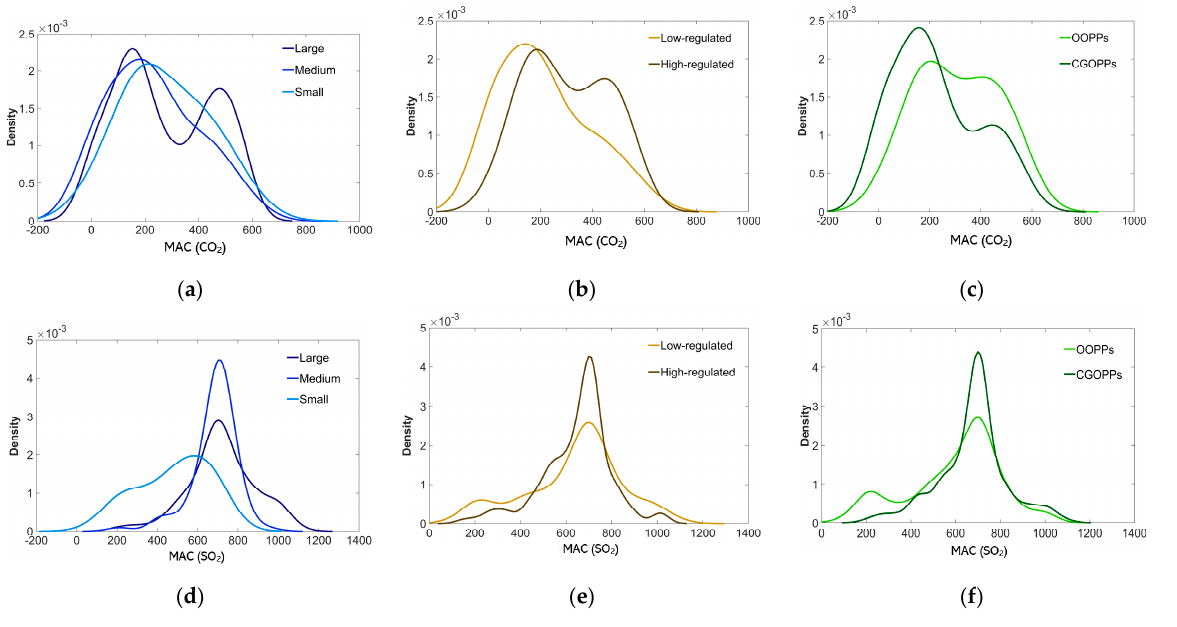
Figure 5. Kernel density distributions of CO 2 and SO 2 marginal abatement costs with different groups: ( a ) Kernel density plot of CO 2 marginal abatement costs for large, medium-sized, and small CFPPs; ( b ) Kernel density plot of CO 2 marginal abatement costs for high- and low-regulated CFPPs; ( c ) Kernel density plot of CO 2 marginal abatement costs for CGOPPs and OOPPs; ( d ) Kernel density plot of SO 2 marginal abatement costs for large, medium, and small CFPPs; ( e ) Kernel density plot of SO 2 marginal abatement costs for high- and low-regulated CFPPs; ( f ) Kernel density plot of SO 2 marginal abatement costs for CGOPPs and